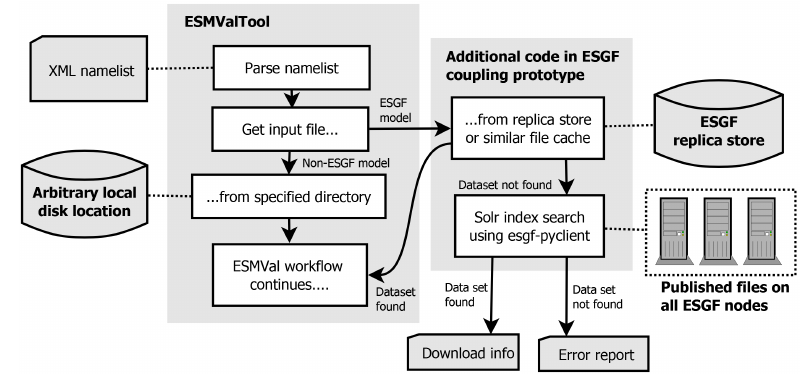
Figure 27. Schematic overview of the coupling of the ESMValTool to the